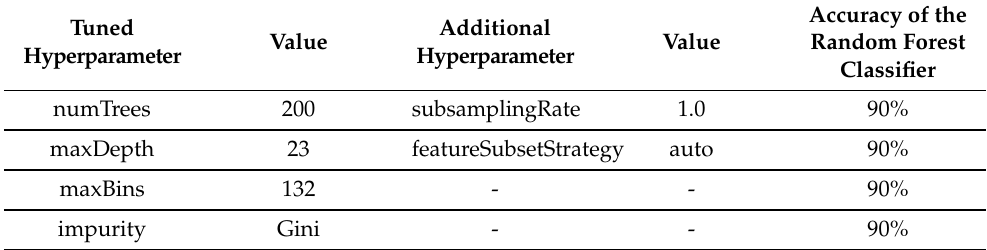
Table 4. Tuned and additional hyperparameters of the developed random forest